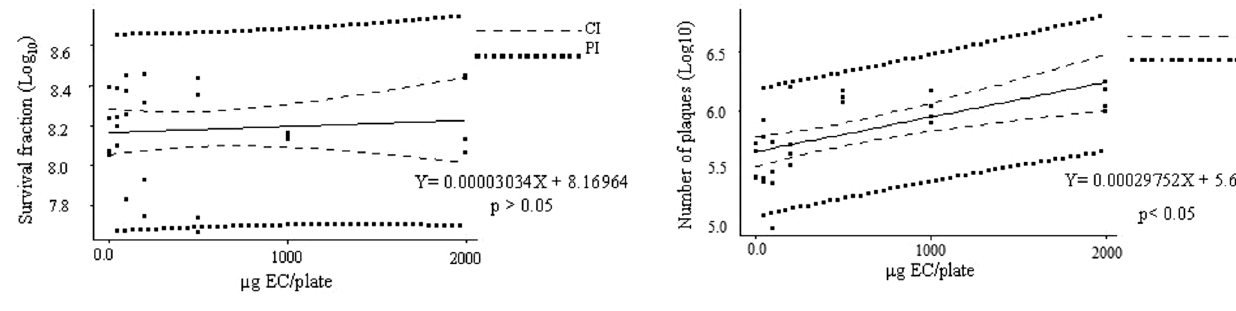
FIGURE 1 - Survival fraction of E. coli WP2s(λ) as a function of the concentration of Curatella americana ethanolic extract. E. coli WP2s(λ) cultures during the exponential phase of growth were centrifuged, resuspended, incubated for 25 min with different concentrations of Curatella americana stem bark ethanolic extract, diluted with M9 buffer, inoculated into LB plates, incubated for 24 h at 37 °C, after what the colonies were counted. CI: 95% confidence interval; PI: 95% predicted interval.